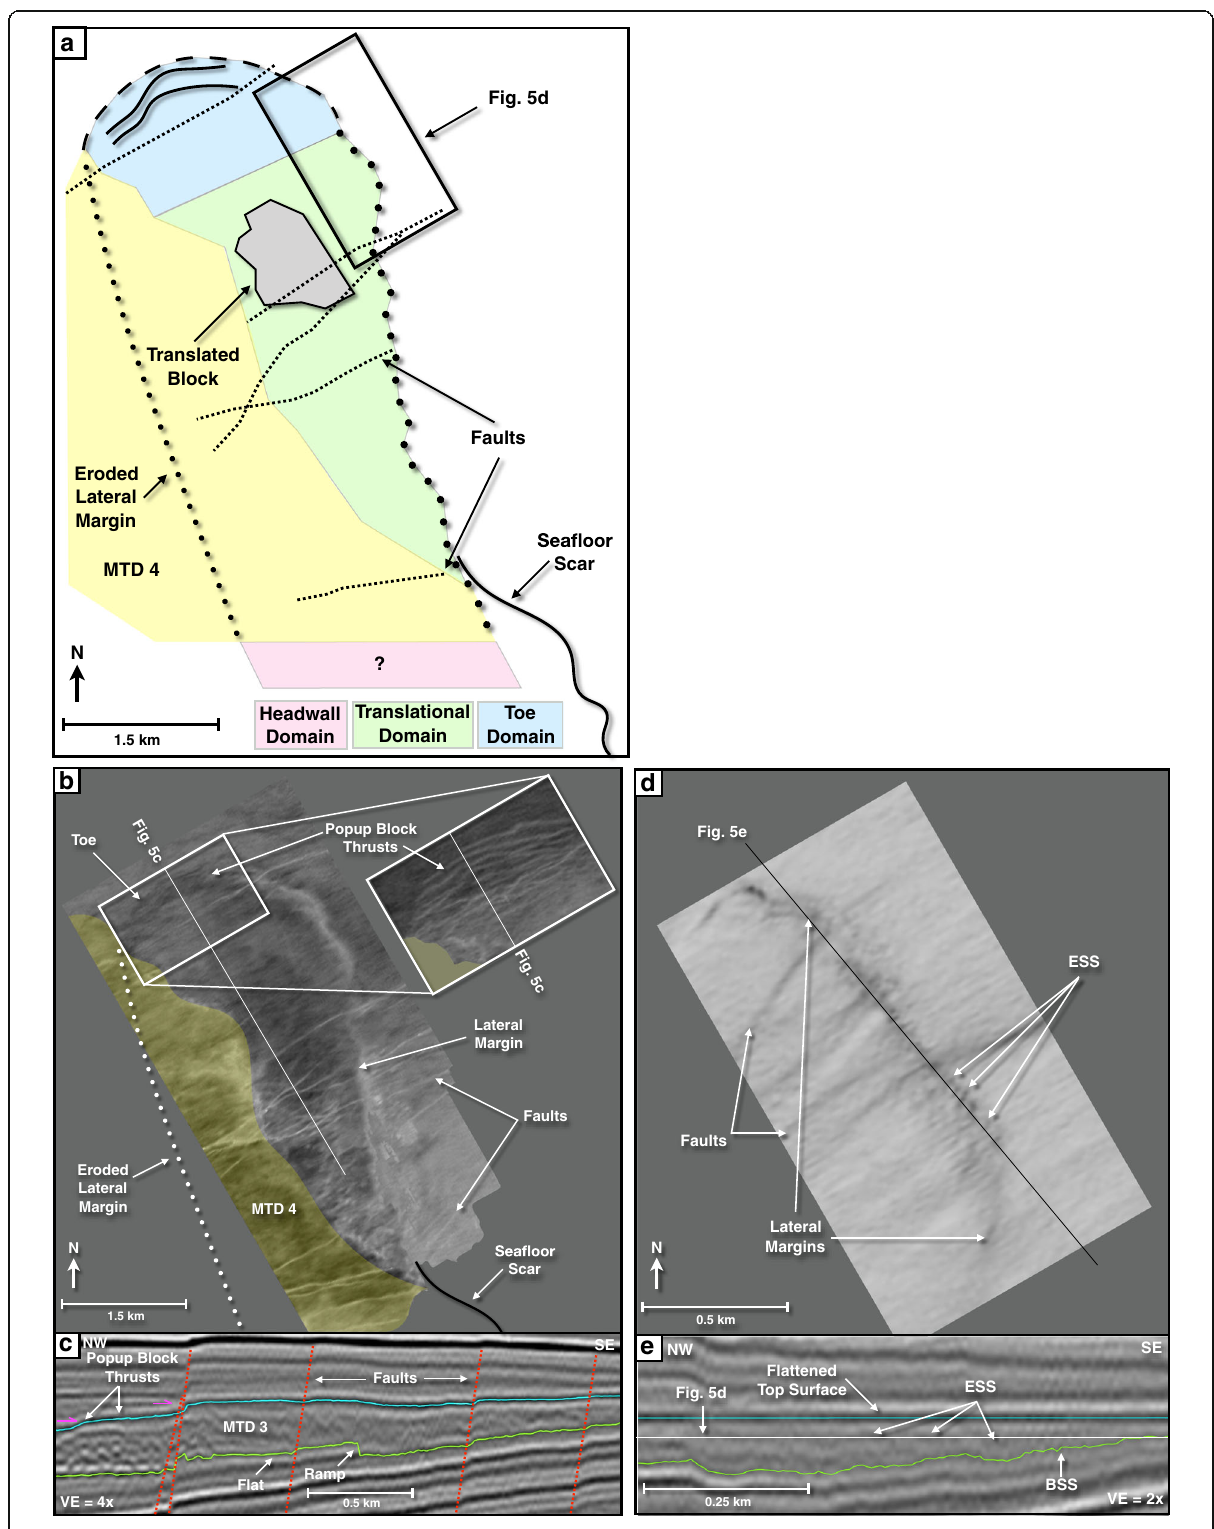
Translational DomainHeadwall